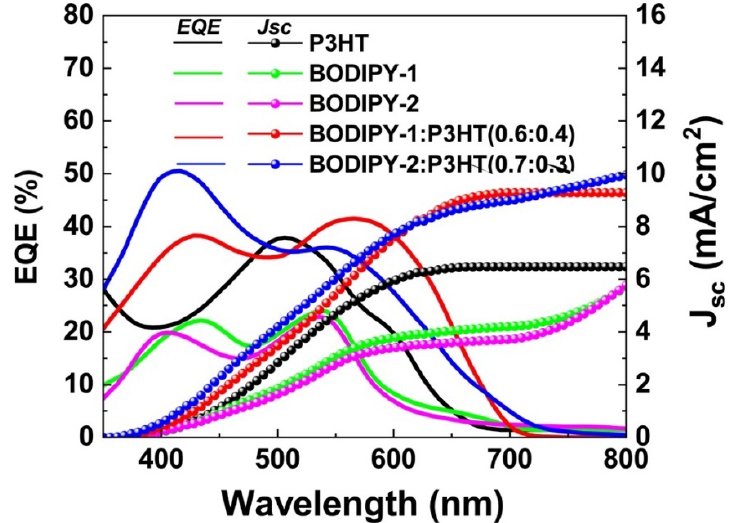
Figure 4. The external quantum efficiency (EQE) spectra of P3HT, BODIPY-1 , and BODIPY-2 binary solar cells and BODIPY-1 :P3HT(0.6:0.4) and BODIPY-2 :P3HT (0.7:0.3) ternary solar cells.